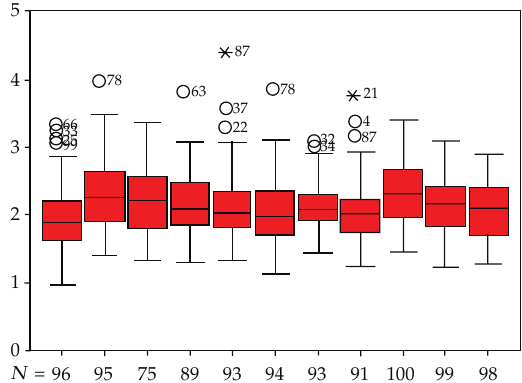
Figure 1: Boxplot of queue discharge